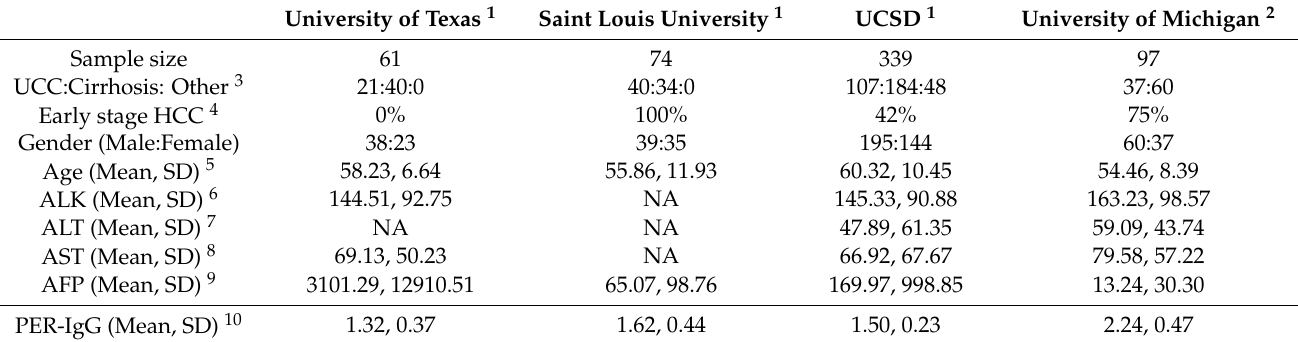
Table 1. Patient